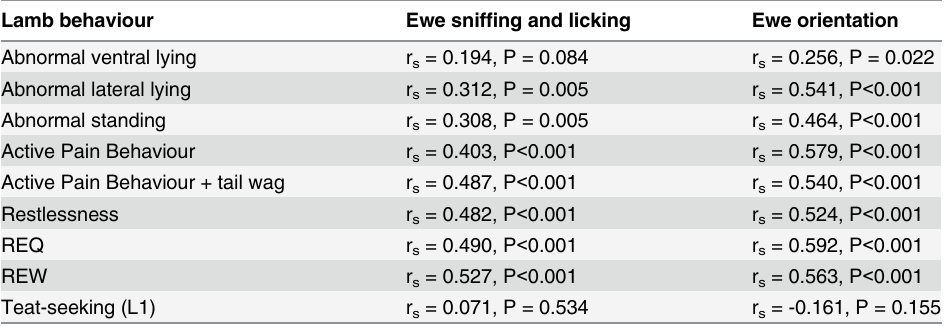
Table 5. Spearman ’ s rank correlation between frequency of ewe maternal behaviour and lamb behav- iours indicative of pain. Lamb behaviour Ewe snif fi ng and licking Ewe orientation Abnormal ventral lying r s = 0.194, P = 0.084 r s = 0.256, P = 0.022 Abnormal lateral lying r s = 0.312, P = 0.005 r s = 0.541, P < 0.001 Abnormal standing r s = 0.308, P = 0.005 r s = 0.464, P < 0.001 Active Pain Behaviour r s = 0.403, P < 0.001 r s = 0.579, P < 0.001 Active Pain Behaviour + tail wag r s = 0.487, P < 0.001 r s = 0.540, P < 0.001 Restlessness r s = 0.482, P < 0.001 r s = 0.524, P < 0.001 REQ r s = 0.490, P < 0.001 r s = 0.592, P < 0.001 REW r s = 0.527, P < 0.001 r s = 0.563, P < 0.001 Teat-seeking (L1) r s = 0.071, P = 0.534 r s = -0.161, P = 0.155 Lamb behaviours are proportion of time spent in different postures and frequency of restlessness, composite pain behaviours, as described in Table 2, and teat-seeking responses. N = 80